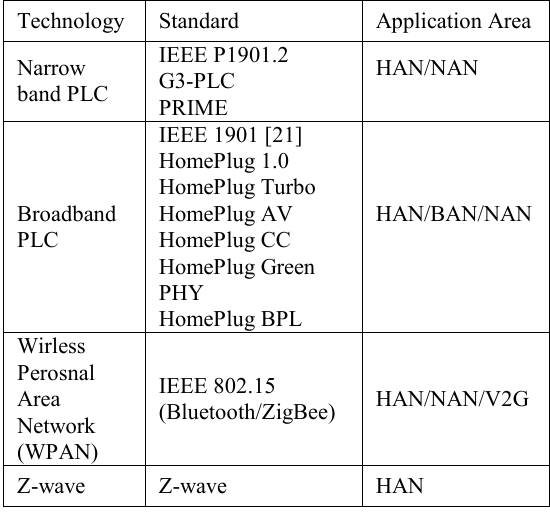
Table 1 . Communications solutions for smart grid